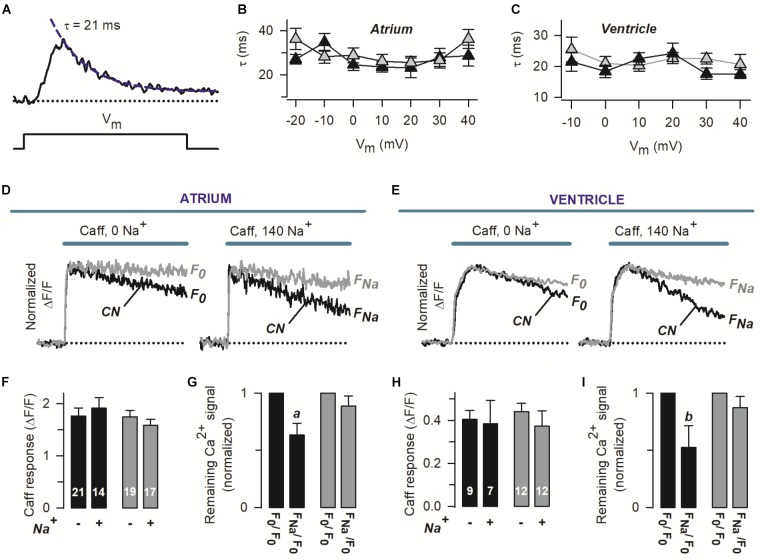
Pirfenidone regulates the rate of Ca2+ extrusion via the NCX, but not SERCA activity. (A) The panel shows a Ca2+ transient recorded as in Figure 1, along with an exponential function (dashed line) describing the decaying phase. The corresponding time constant (τ) is also indicated. (B,C) Average values of τ that were obtained as in (A), as a function of Vm. (D,E) Representative Ca2+ transients that were induced by a double pulse of caffeine (Caff), initially in the absence (0 Na+) and then in the presence of 140 mM extracellular Na+ (140 Na+). Recordings were obtained from four different myocytes (two atrial–D and two ventricular–E). F0 and FNa stand for the Ca2+ signal remaining at the end of caffeine applications, in the absence and presence of Na. The traces are shown normalized to peak caffeine response (FPeak), to emphasize kinetic differences. (F,H) Absolute average values of FPeak (Caff response) and number of investigated cells. (G,I) For each particular cell, F0 and FNa (see D,E) were normalized with respect to F0, and the resulting values were pooled and averaged. In all panels, black and gray symbols/traces denote control (CN) and PFD-treated cells, respectively. ap < 0.005, bp < 0.05; compared with the matching F0/F0 condition (paired t-test).